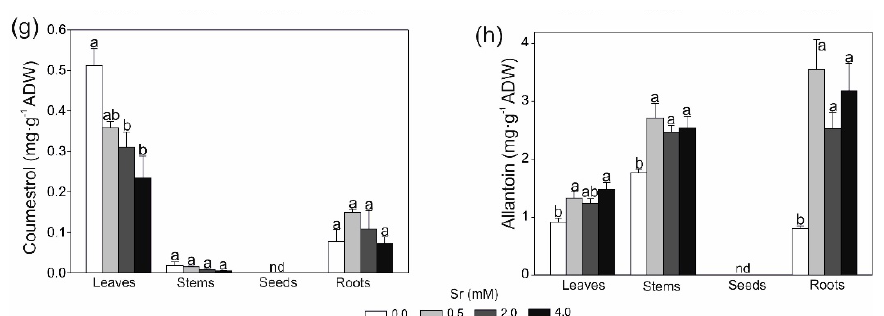
Figure 1. Effect of various strontium concentrations on the content of phytoestrogens and allantoin in air-dry weight (ADW) of different soybean organs; ( a ) daidzin; ( b ) glycitin; ( c ) genistin; ( d ) malonyldaidzin; ( e ) malonylgenistin; ( f ) daidzein; ( g ) coumestrol; ( h ) allantoin. Data are means ± SE ( n = 4); * nd-not detected. Values followed by the same letters within the same plants’ organ are not significantly different ( p < 0.05, Tukey’s test).